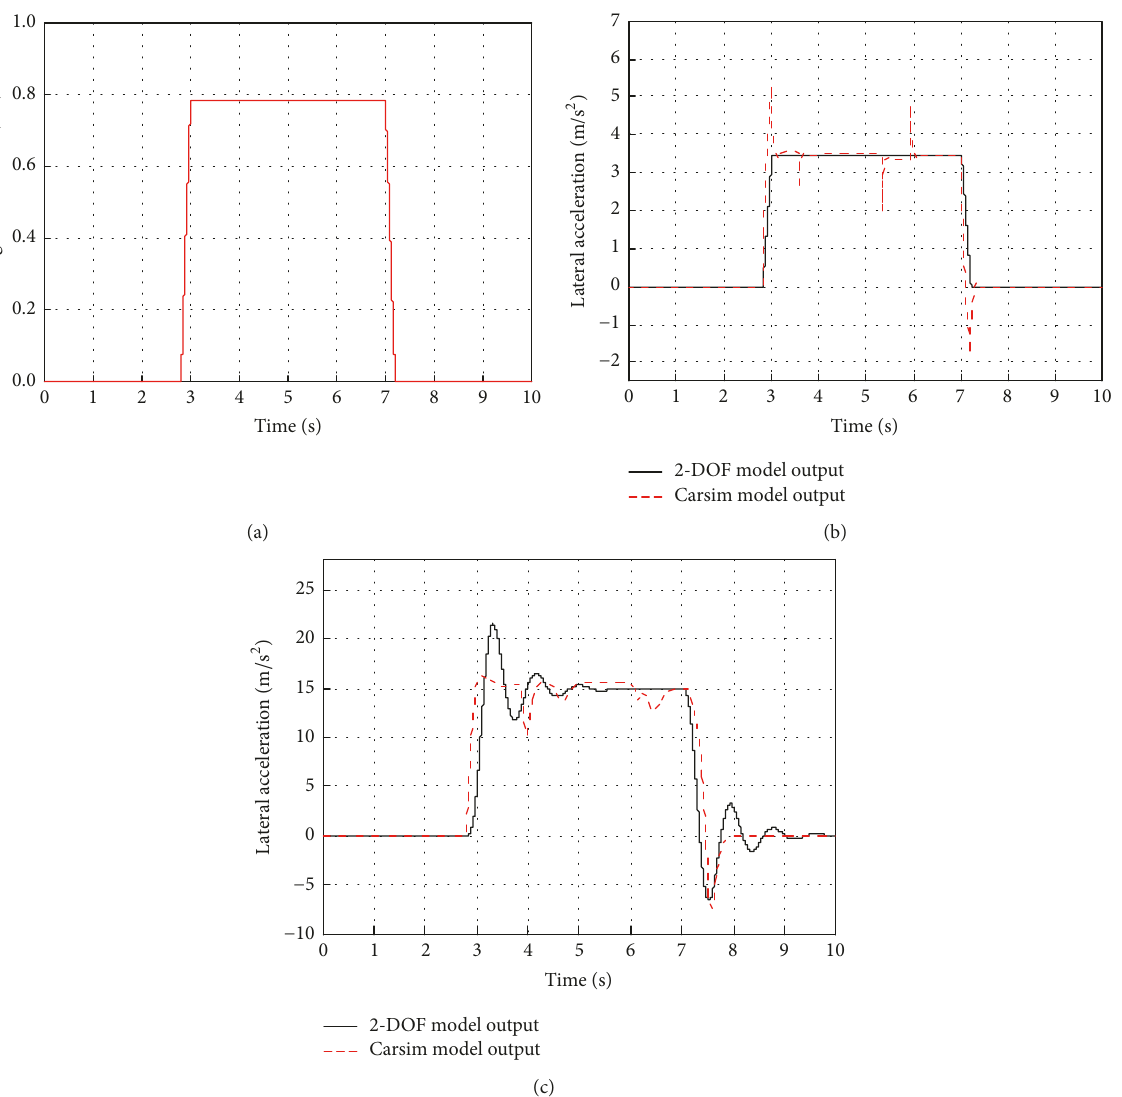
Figure 5: Identification results of the Carsim vehicle model. (a) Input signal. (b) V = 20 km/h. (c) V = 90 km/h.